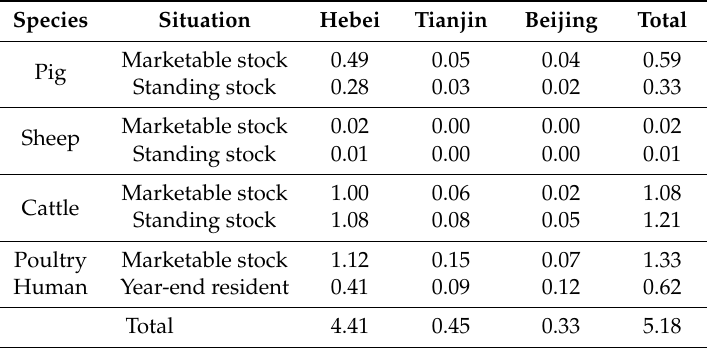
Table 10. The coal equivalent of feces waste (10 6